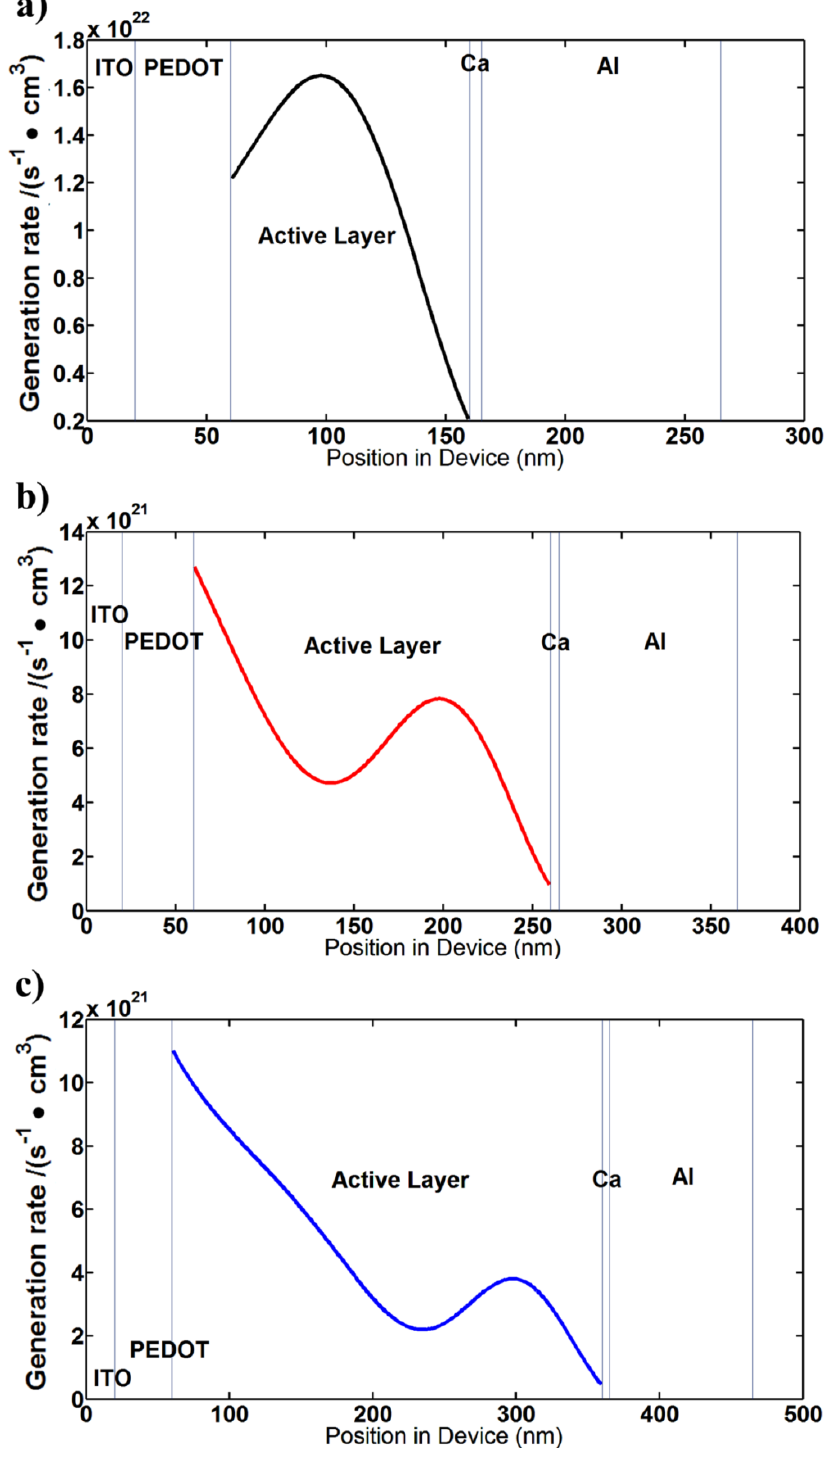
Figure 4. Simulation results of charge generation rates of SM BHJ OSCs: ( a ) BHJ active layer = 100 nm; ( b ) BHJ active layer = 200 nm; ( c ) BHJ active layer = 320 nm.